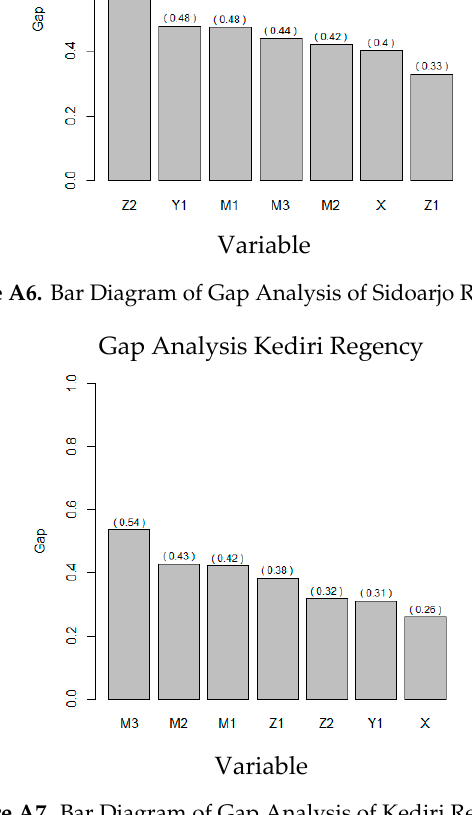
Variable Figure A8. Bar Diagram of Gap Analysis of Kediri City. Gap Analysis Blitar Regency